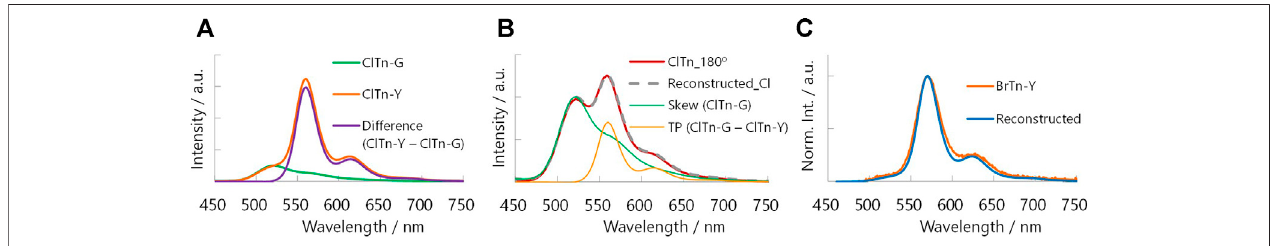
FIGURE9|(A) DeconvolutionofthePLspectrumof ClTn-Y (orange)bysubtractingthatof ClTn-G (green). (B) ReconstructingthePLspectrumofpartiallyground ClTn (red, 180 ° in Figure 7A ) from those of the skew (green) and TP conformer (orange). (C) Reconstructed Φ p -weighted PL spectrum of ClTn-Y (blue, shifted by – 10 nm) and the PL spectrum of BrTn-Y (orange).